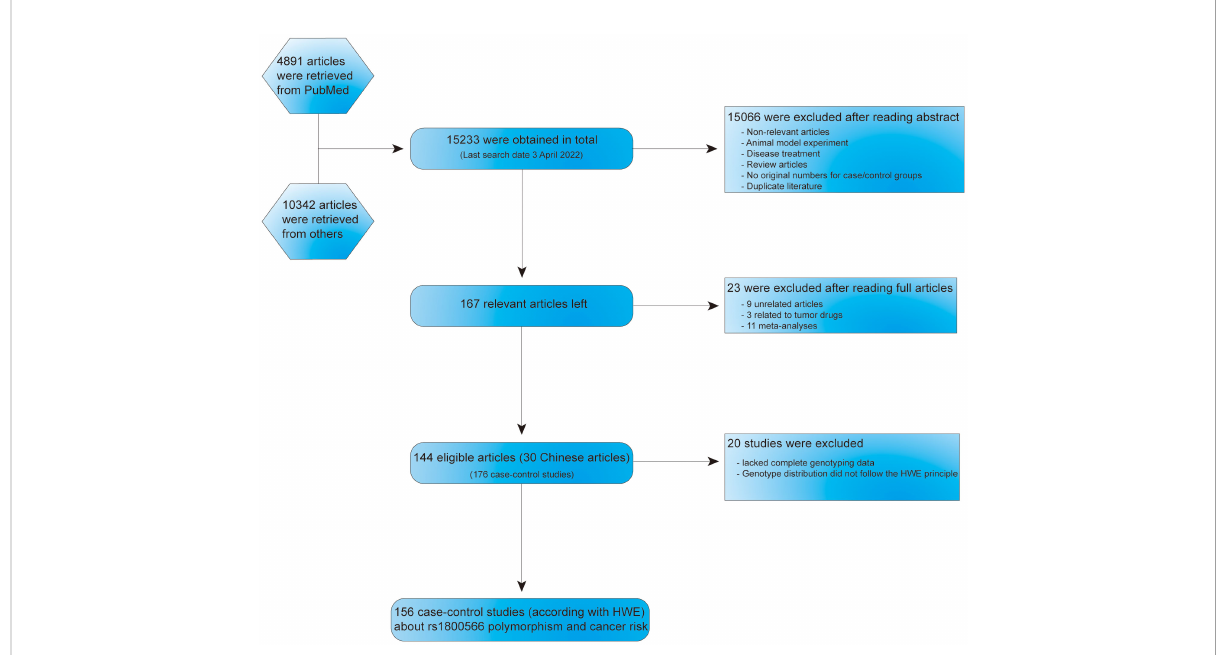
FIGURE 1 Flow chart about the search and screening strategies for NQO1 rs1800566 polymorphism studies from several